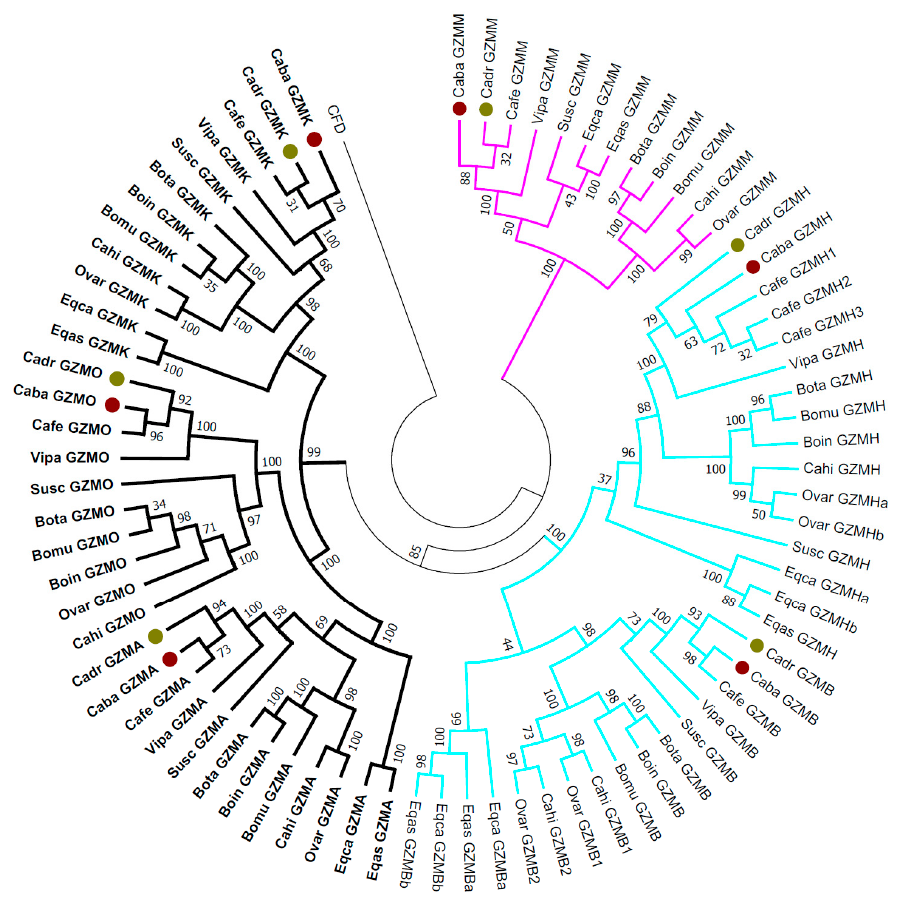
Figure 3. Phylogeny of granzymes in domesticated ungulates. Amino acid sequences for granzyme A (GZMA), granzyme B (GZMB), granzyme H (GZMH), granzyme K (GZMK), granzyme M (GZMM), and granzyme O (GZMO) of dromedary (Cadr) and Bactrian camel (Caba), highlighted by color dots, were compared to reference sequences (for accession numbers see Table S2) of wild camel (Cafe), alpaca (Vipa), swine (Susc), goat (Cahi), sheep (Ovar), cattle (Bota), zebu cattle (Boin), wild yak (Bomu), horse (Eqca) and donkey (Eqas), and analyzed in MEGA X. The evolutionary history was inferred by the Neighbor-Joining method and the evolutionary distances were computed using the p-distance method. The bootstrap consensus tree rooted to human complement factor D (CFD) is presented and the percentages of concordant replicates in the bootstrap test (1000 replicates) are shown next to the branches. Bold—trypsin-like locus; cyan—chymotrypsin-like locus; magenta—metase-like locus.